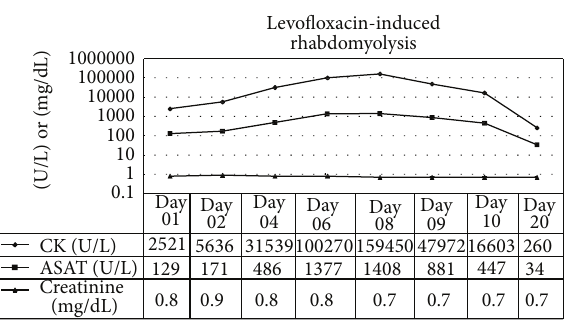
Figure 1: Serum creatinine, creatine kinase [CK], and aspartate aminotransferase [ASAT] during the severe clinical course. Notice the same curve morphology regarding the CK and ASAT